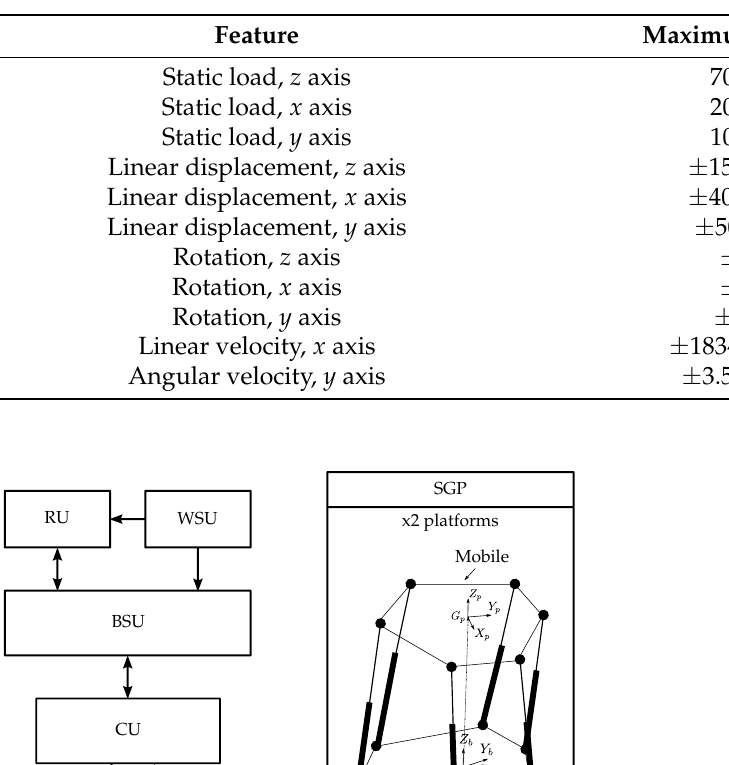
Table 1. Gait simulator workspace and output forces [20].